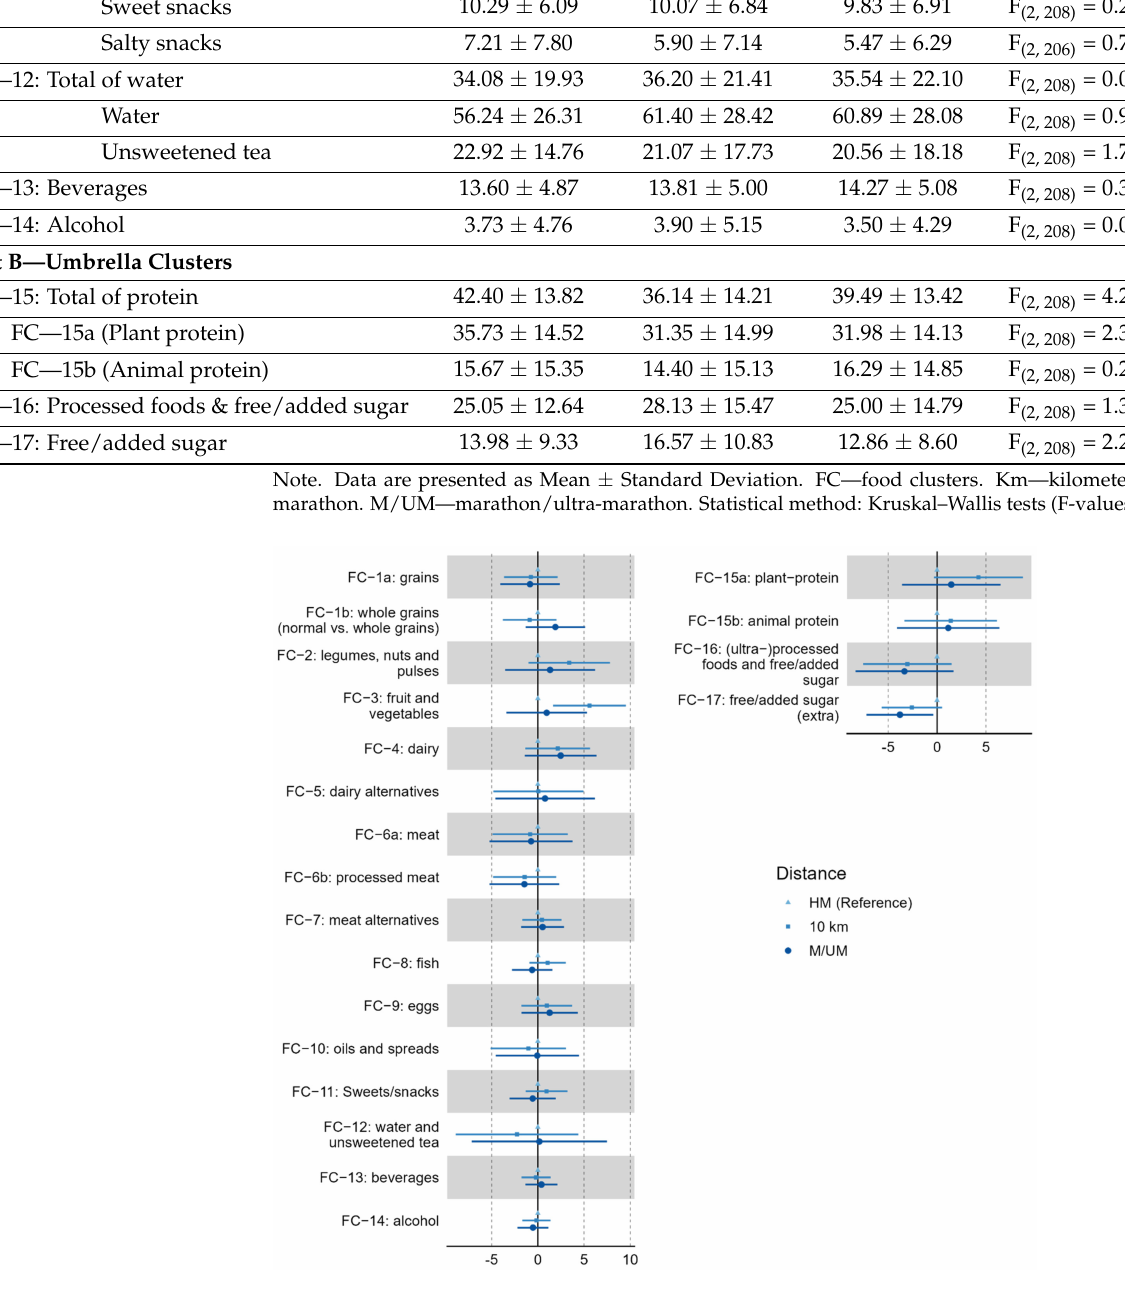
Figure 2. Forest plots with standardized regression coefficient, including 95% of confidence interval to display differences between race distance groups in basic (left graphic) and umbrella (right graphic) food clusters. The half-marathon group is considered the reference, and the differences are shown based on variations of 10-km and (ultra-)marathon runners from half-marathoners. FC—food clusters. HM—half-marathon.